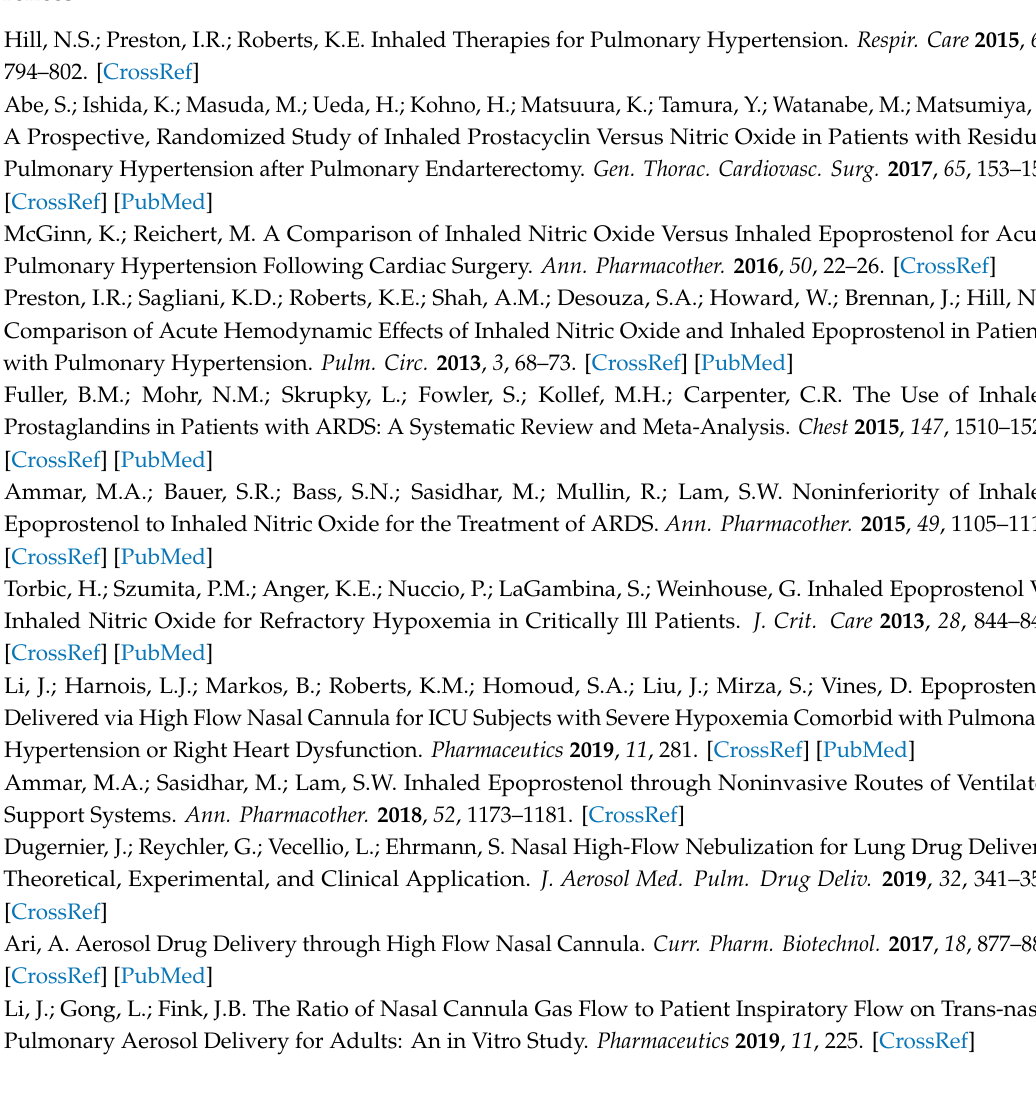
of hemodynamic responses pre and post iEPO for female patients, Table S3.2: Comparison of parameters and oxygenation responses pre and post iEPO for female patients, Table S3.3: Comparison of hemodynamic responses pre and post iEPO for male patients, Table S3.4: Comparison of parameters and oxygenation responses pre and post iEPO for male patients, Table S3.5: Comparison of demographic information and outcome between male and female patients, Table S4.1: Response to iEPO via HFNC between patients with and without type I pulmonary hypertension, Table S4.2: Comparison of oxygenation response to iEPO via HFNC using flow titration versus constant flow in patients with type I pulmonary